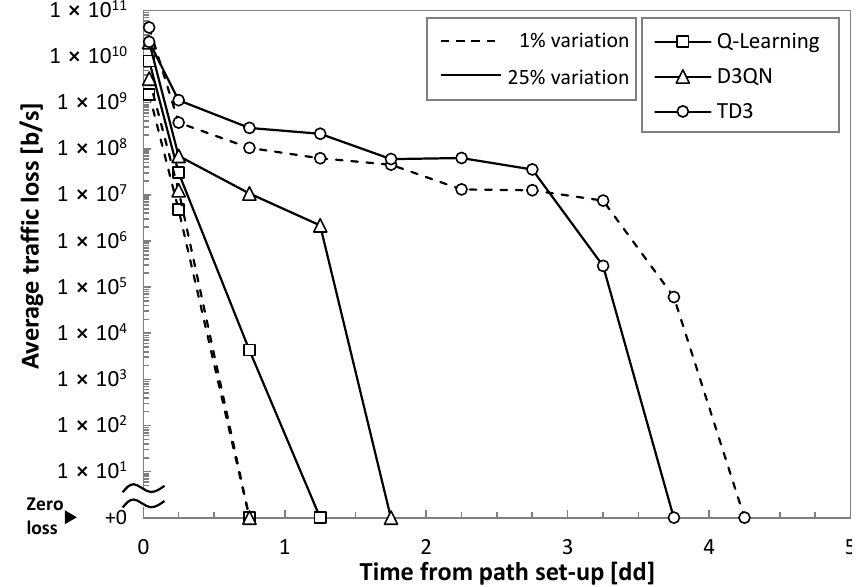
Figure 8. Achieving zero loss operation.